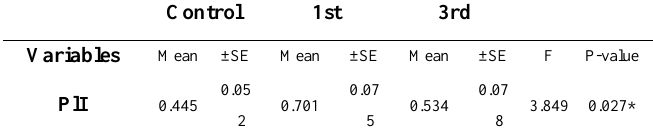
Table 2 : Descriptive and statistical test of PlI among groups